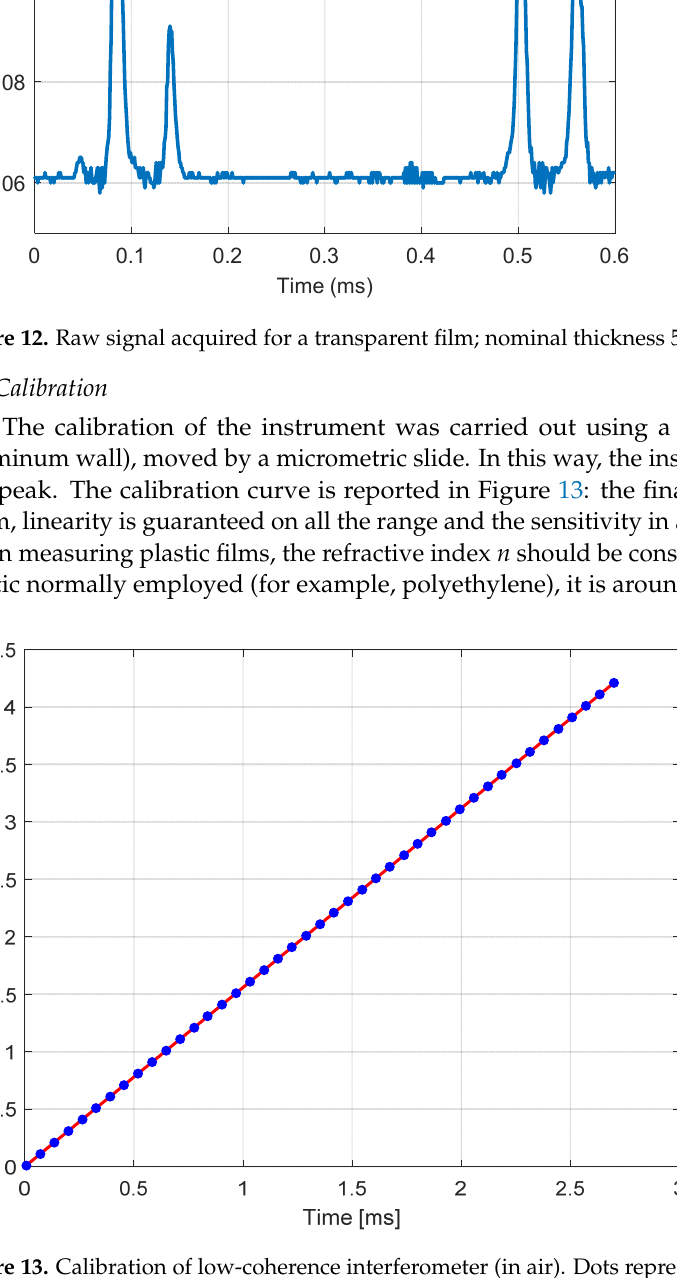
Figure 13. Calibration of low-coherence interferometer (in air). Dots represent measured data while the line is the linear fitting curve. The measurement range of about 4 mm is centered at 25 mm from the output lens (see Figure 8).